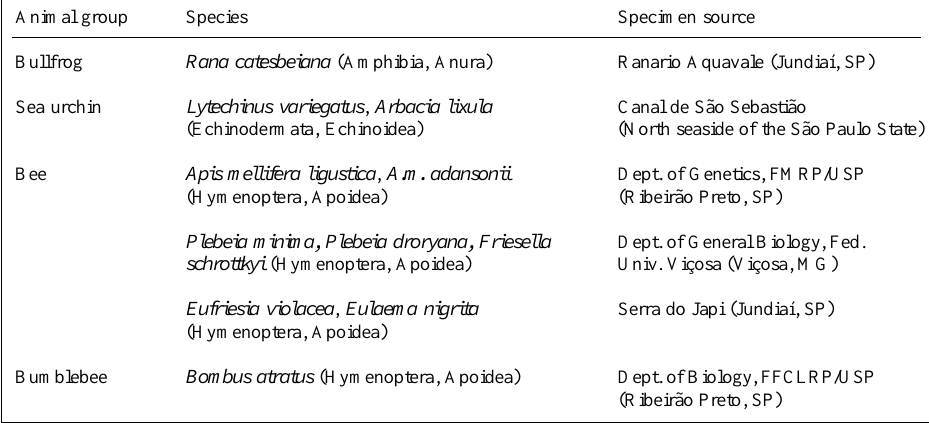
Table I - Species and specimen source investigated for sperm nucleoprotein cytochemistry. Animal group